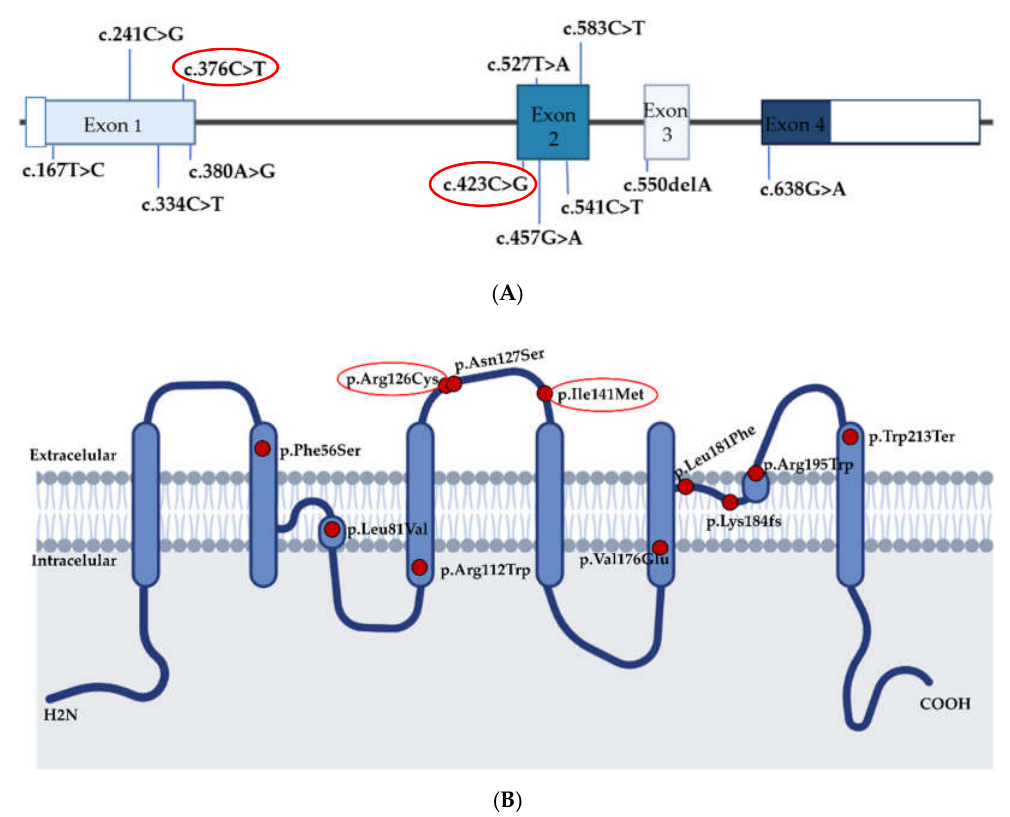
Figure 3. Variants described in AQP1 . ( A ) Localization of cDNA variants detected in PAH cases in AQP1 . ( B ) Representation of AQP1 protein and the amino acid changes detected in PAH cases. The two variants described in this study are labeled in the red circle; both are located at extracellular domains of the AQP1 protein. Variants were annotated with NM_198098.3.